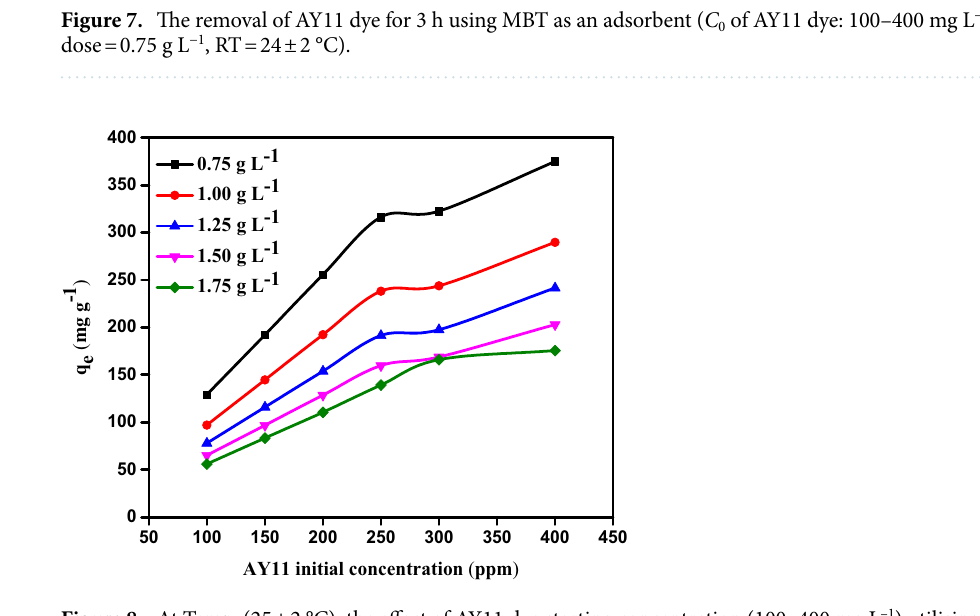
Figure 8. At Temp. (25 ± 2 °C), the effect of AY11 dye starting concentration (100–400 mg L –1 ) utilising